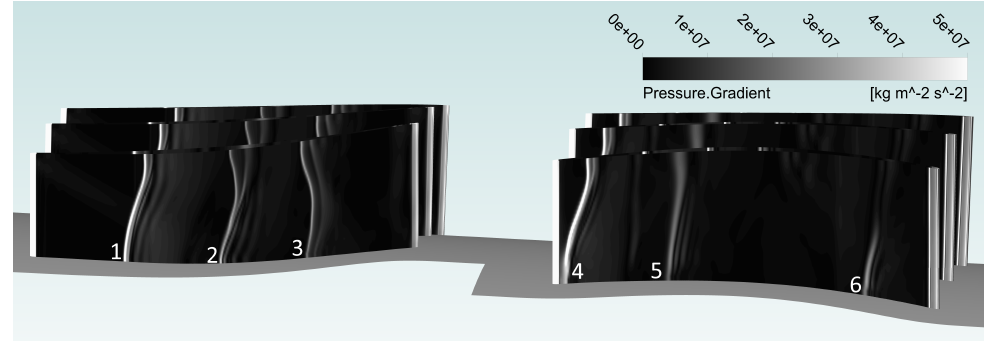
Figure 20. The 3D shock structure visualization on stator suction side and rotor pressure side for design point